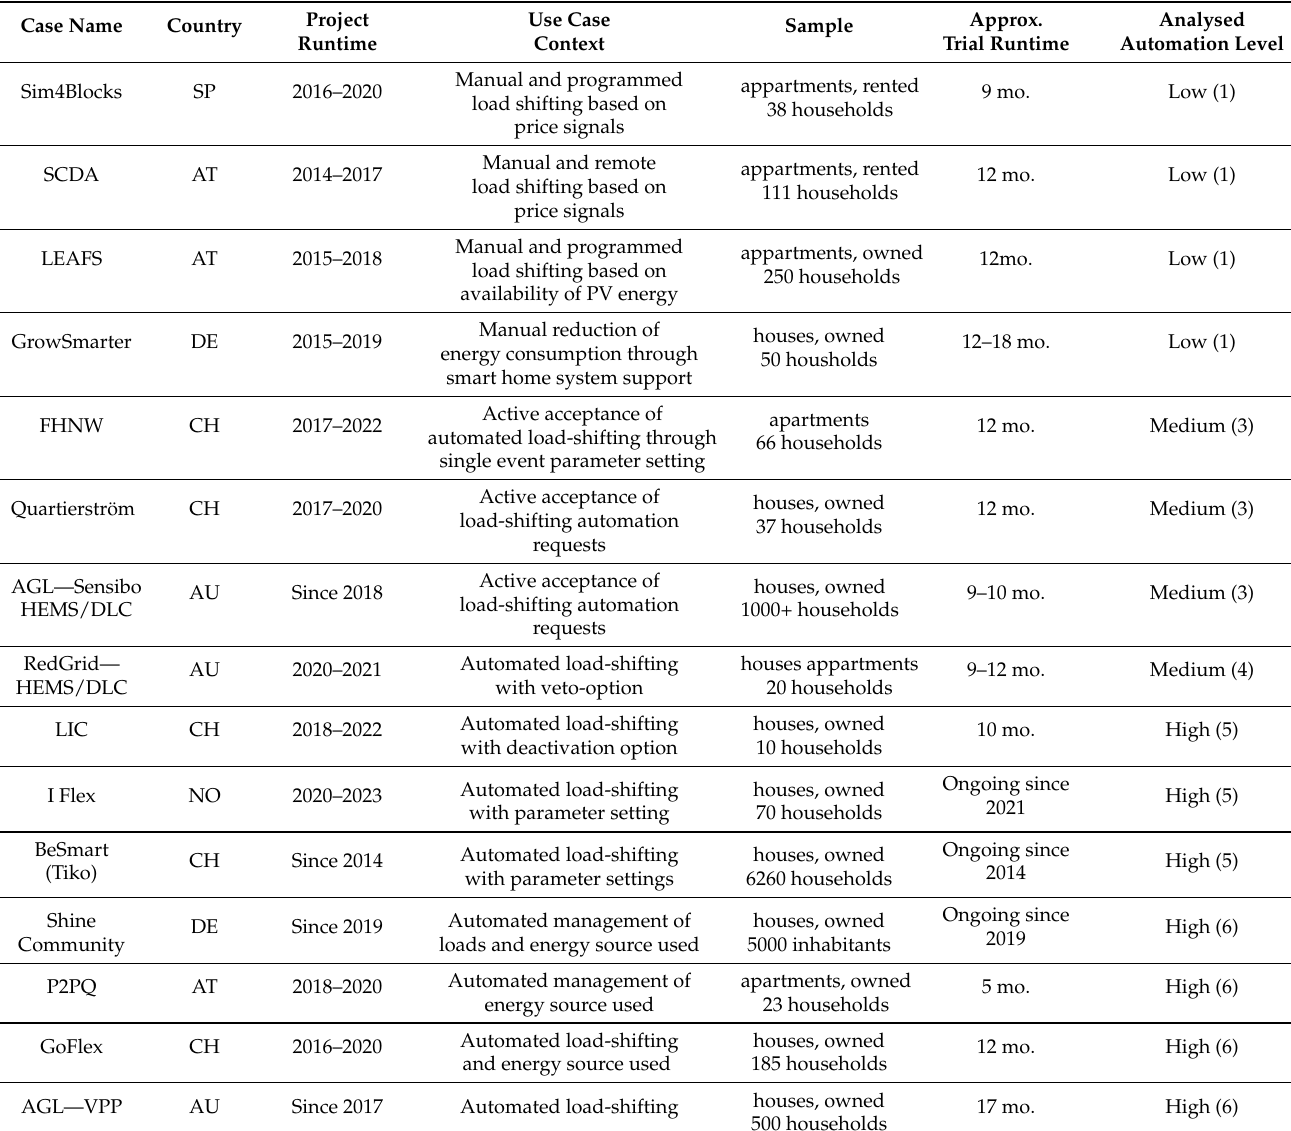
Table 1. Overview of all analyzed use cases and their relevant